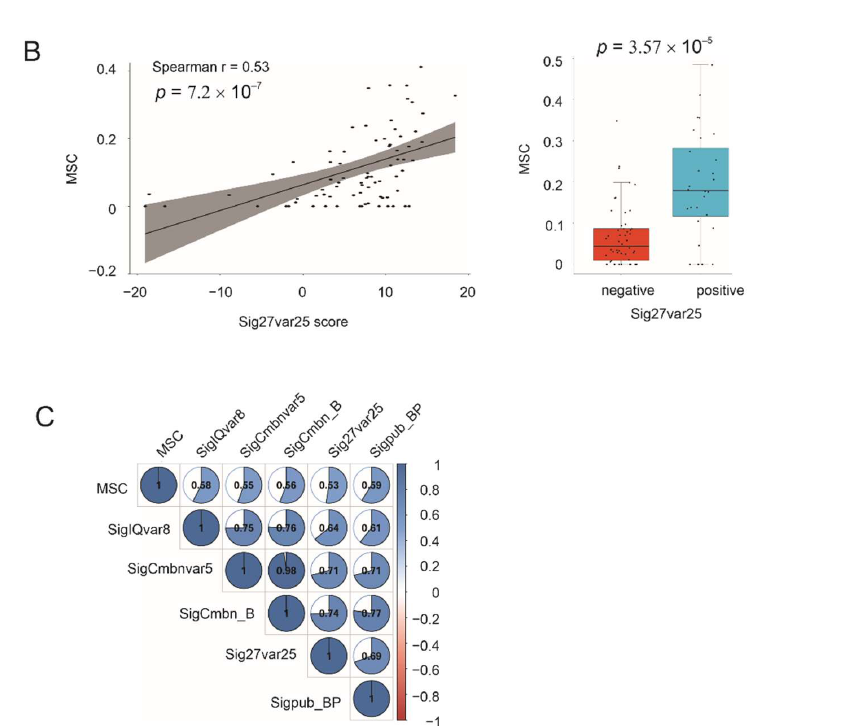
Figure 10. Correlation of multigene signatures with MSC. ( A ) MSCs in ACC were profiled using xCell within the MSDIC R package. Cutoff points for OS and PFS were estimated using Maximally Selected Rank Statistics, which were used to construct the survival curves. ( B ) Correlation of MSC with Sig27var25 score (left panel) and enrichment of MSCs in Sig25var25 positive ACCs (right panel). The positive and negative statuses were defined according to the empirically derived cutoff point. ( C ) Correlations of MSC with the indicated signatures were determined by Spearman correlation; all correlations are at p < 0.01.